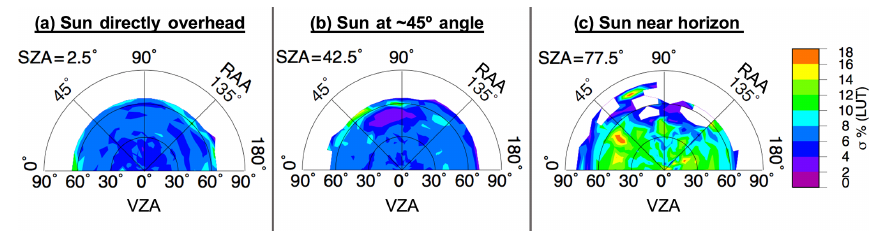
Figure 5. Uncertainty of the LUT shown in Fig. 3 given as the standard deviation percentage of the average bin reflectance.